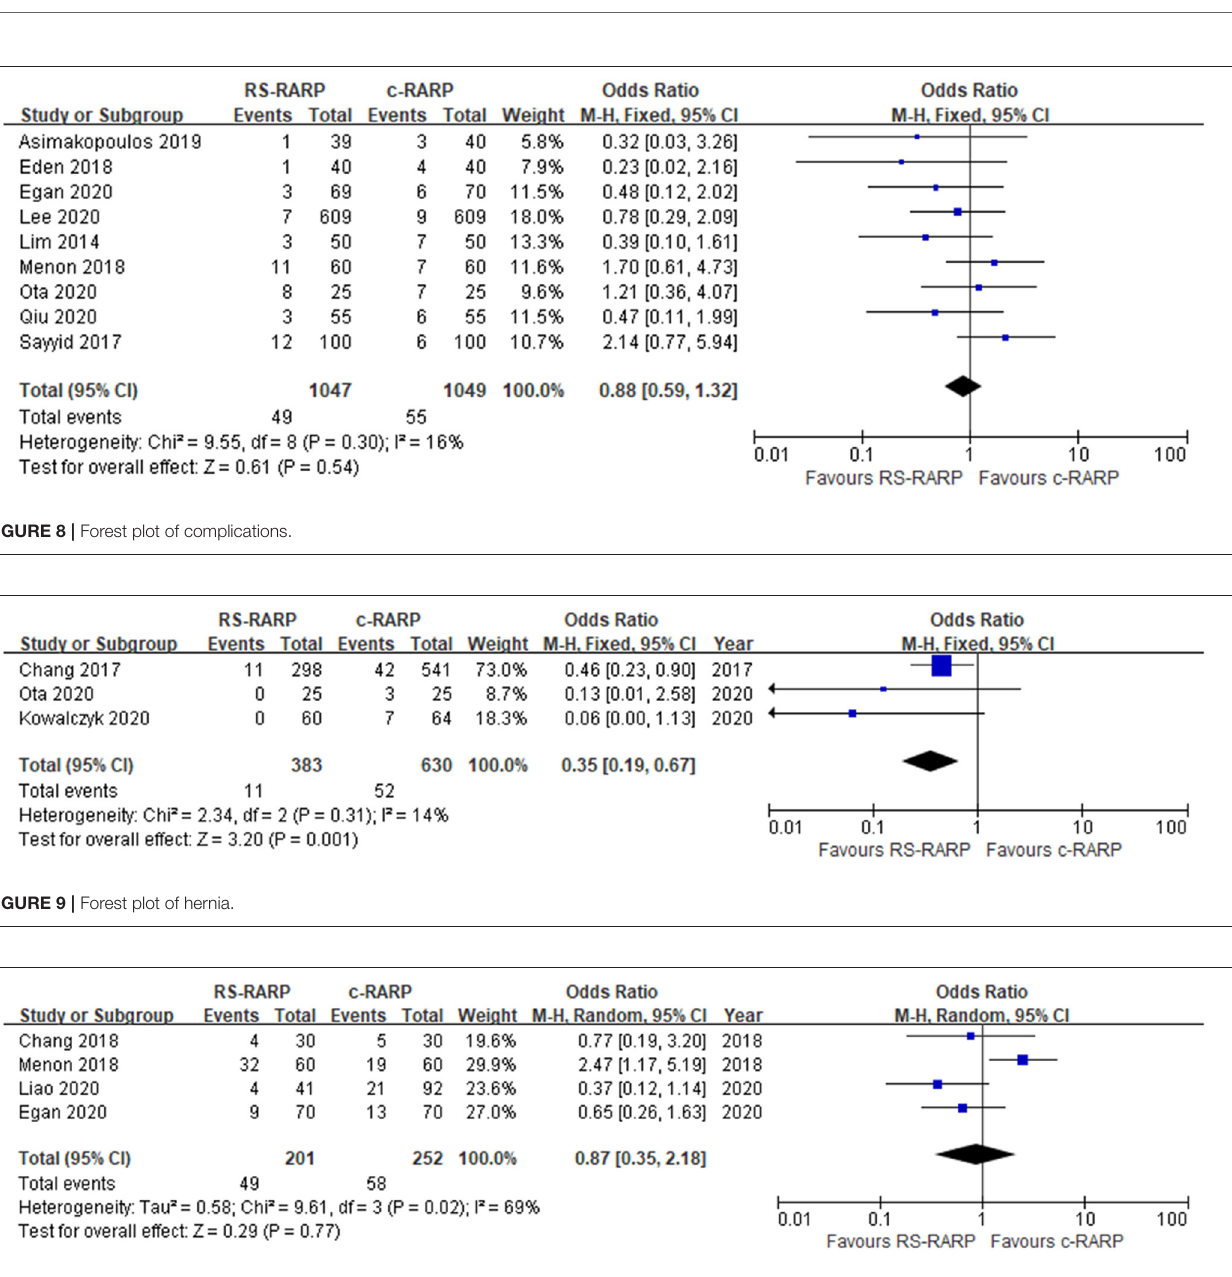
FIGURE 10 | Forest plot and of 1-year-biochemical recurrence